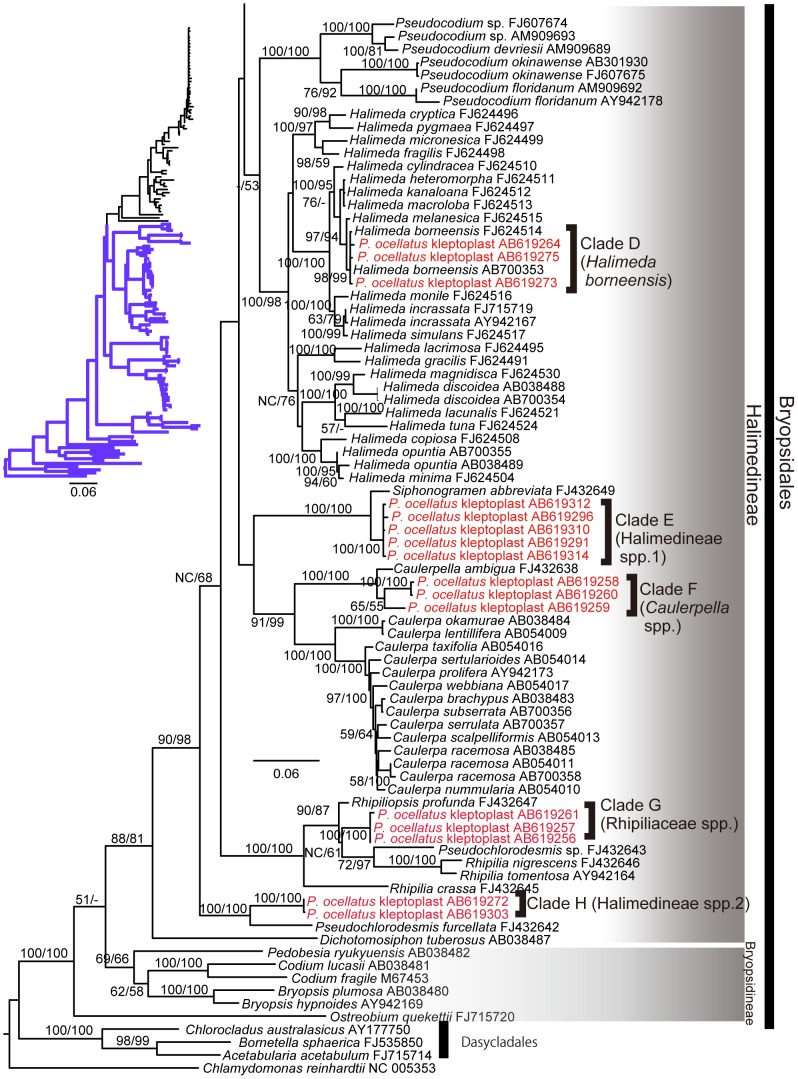
Phylogenetic tree based on rbcL sequences (continued).